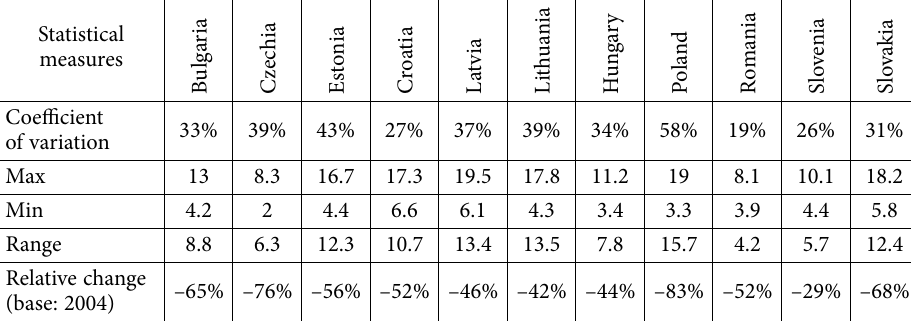
Range Relative change (base: